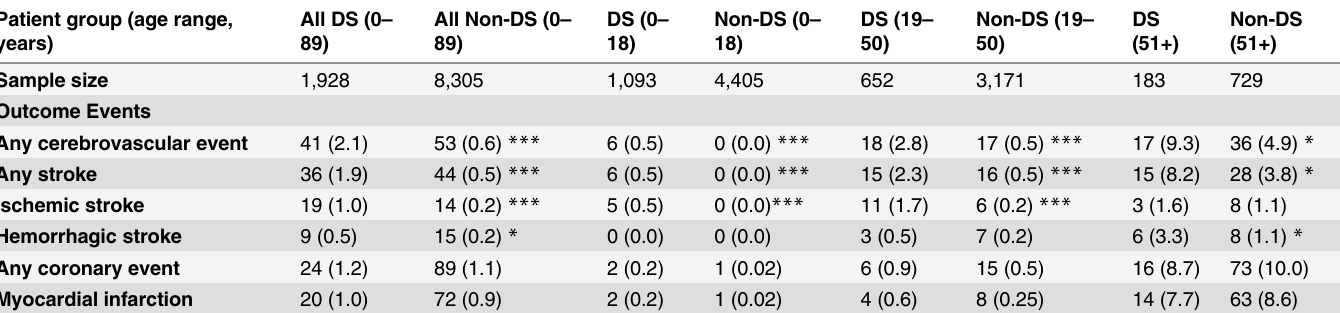
Table 3. Major cardiovascular events in females. (Data are n [%] patients unless indicated otherwise). Patient group (age range,